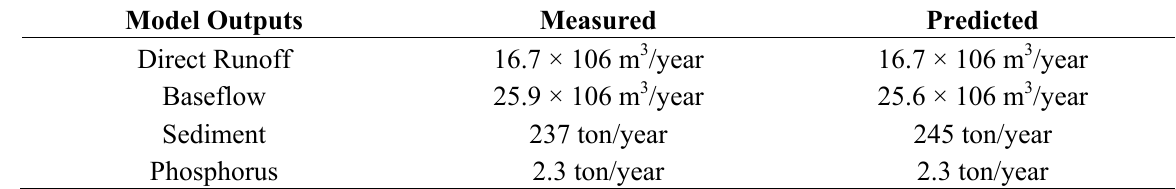
Table 6. Average annual direct runoff, baseflow and sediment